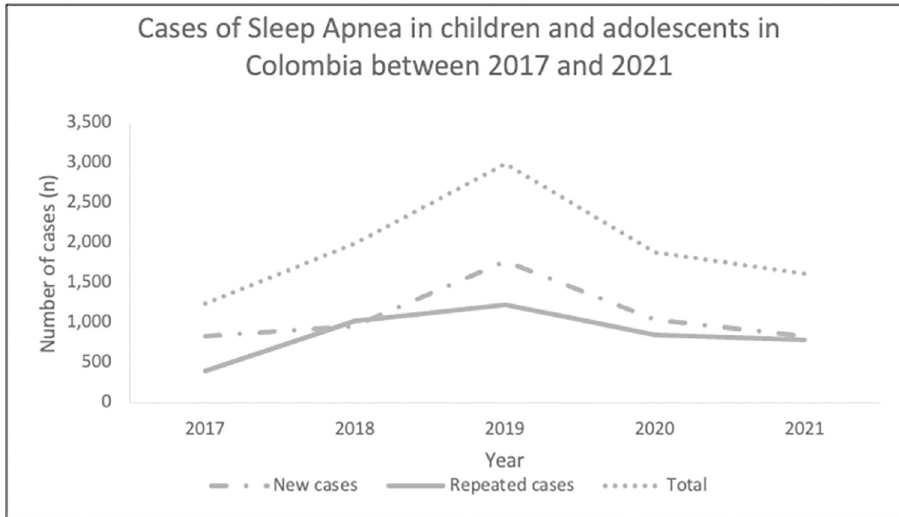
Fig 1. Cases of sleep apnea in children and adolescents in Colombia between 2017 and